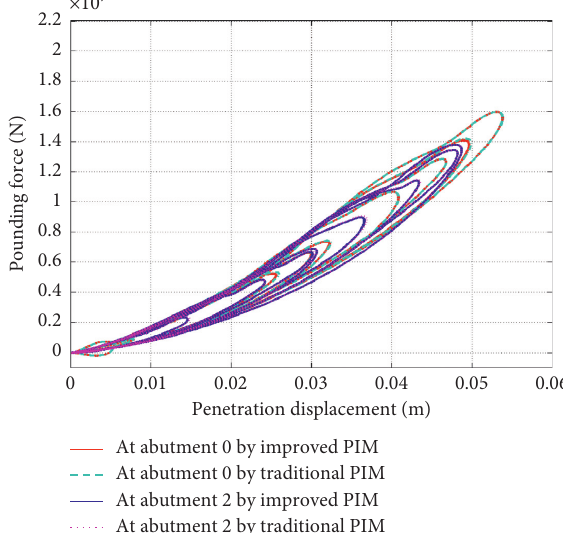
Figure 7: Pounding force-penetration displacement curve under rare earthquake